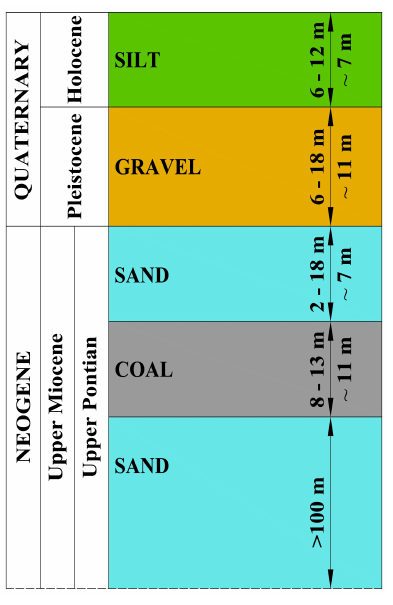
Figure 4. Coal and gravel deposit “Kovin” simplified geological profile.